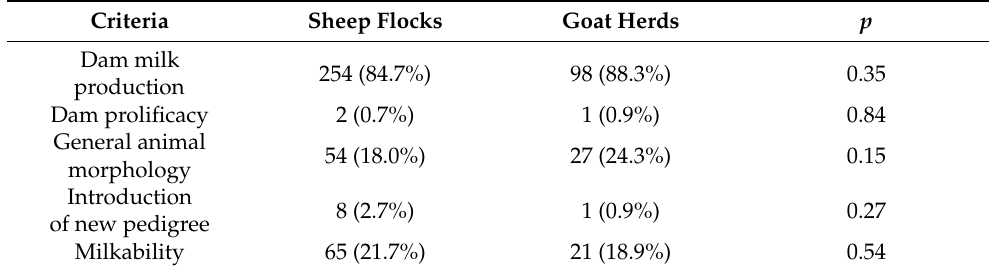
Table 5. Criteria evaluated by farmers for sourcing replacement animals from their own farms.